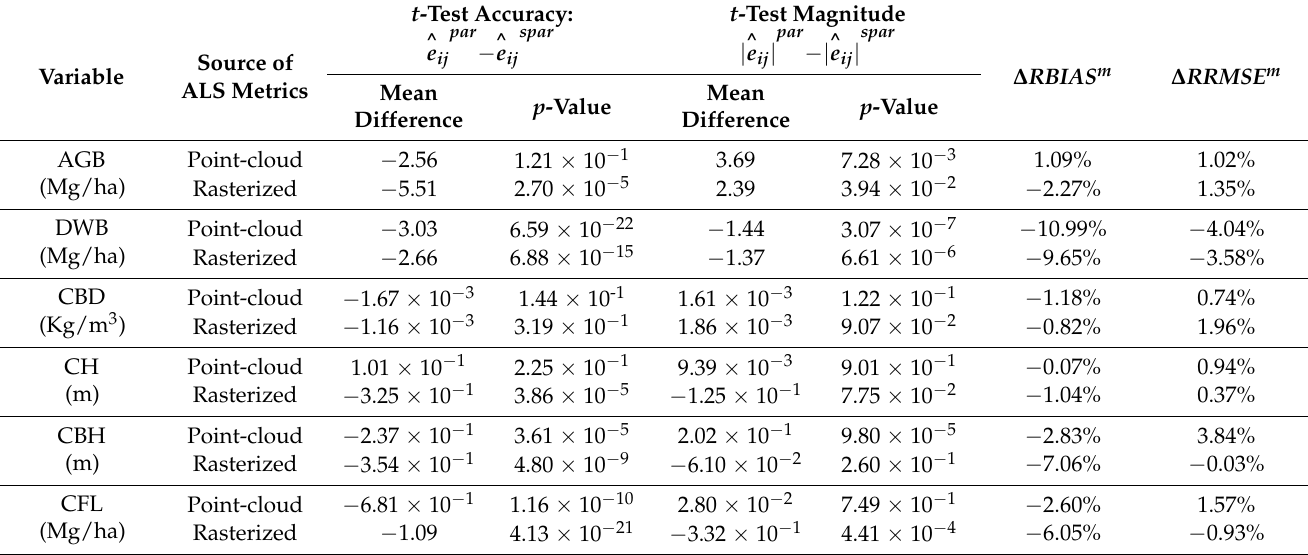
Table 4. Differences between parametric and semiparametric models. AGB, DWB, CBD, CH, CBH, and CFL respectively indicate aboveground biomass, downed woody biomass, canopy bulk density, canopy height, canopy base height, and canopy fuel load. Superscripts p and sp indicate error metrics for parametric and semiparametric models respectively and the superscript m denote changes in RBIAS and RRMSE due to using a different modeling